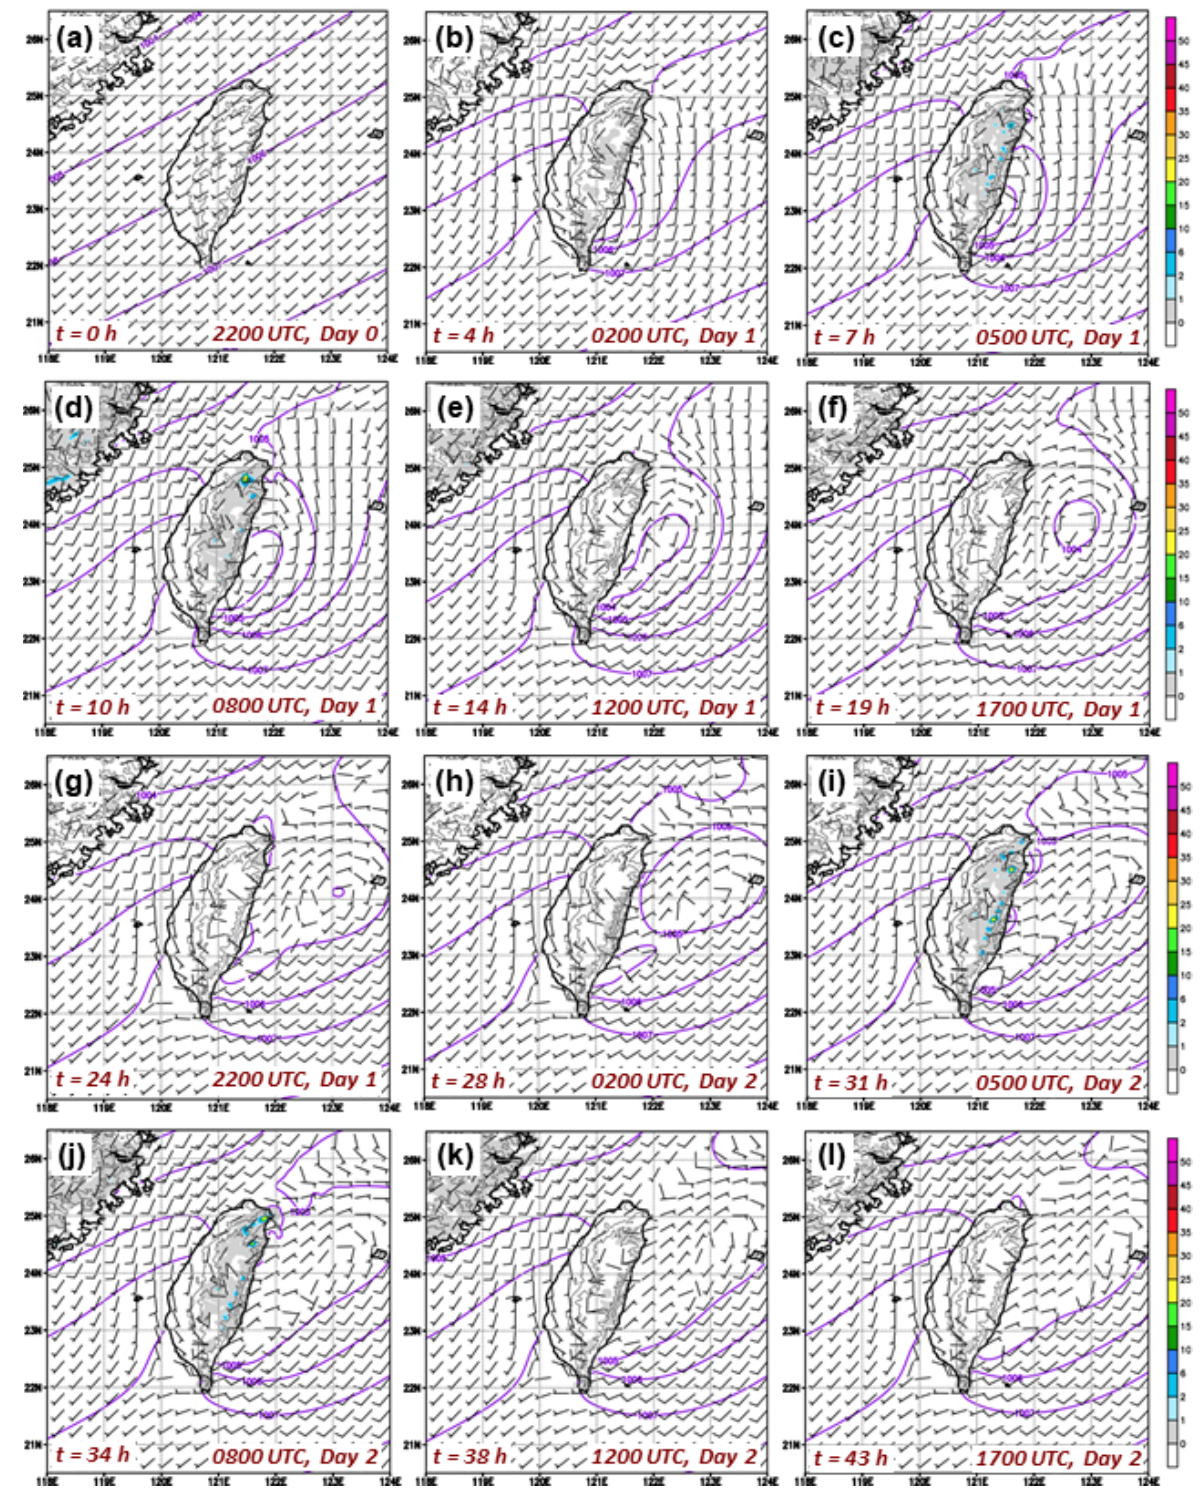
Figure 4. The distributions of sea-level pressure (hPa, isobars, every 1hPa; ocean only), surface wind (ms − 1 , wind barbs; half barb = 5ms − 1 and full barb = 10ms − 1 ), and hourly rainfall (mm, color) at intervals of 3–5h from (a) 0h to (l) 43h in the CTL experiment. The height con- tours at 0.25 and 1km are also drawn over land (gray contours). The local standard time (LST) is UTC + 8h (i.e., 00:00UTC =